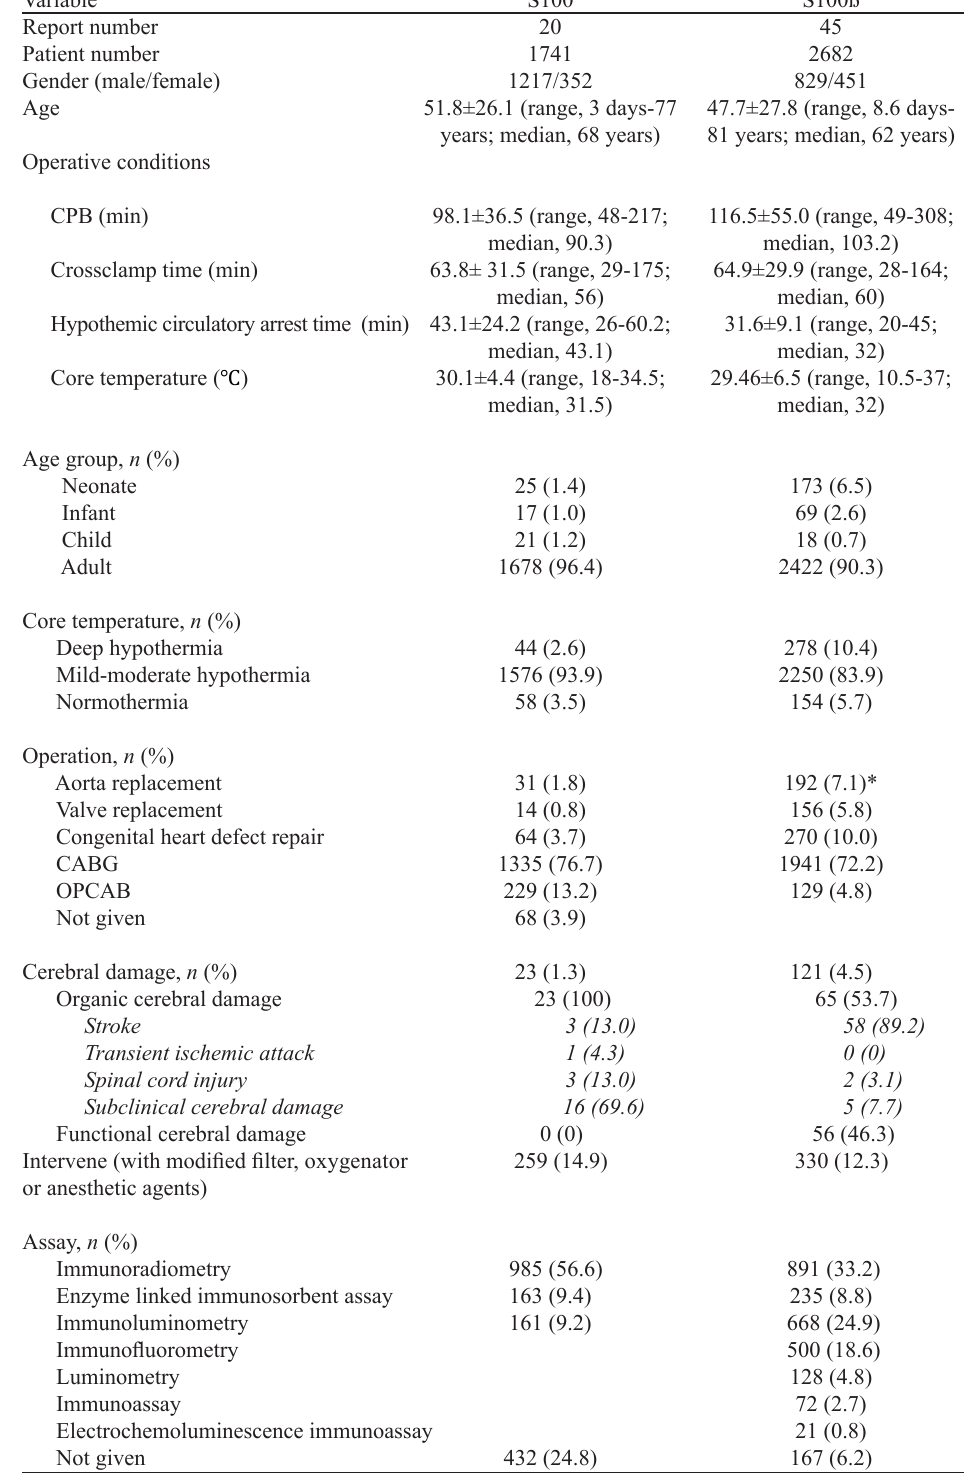
Table 1. Demographics of patients with serum S100 and serum S100ß detections.